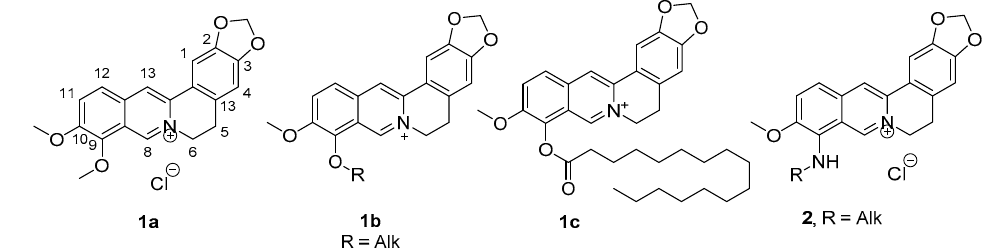
Figure 1. Structures of berberine and its derivatives with hypoglycemic